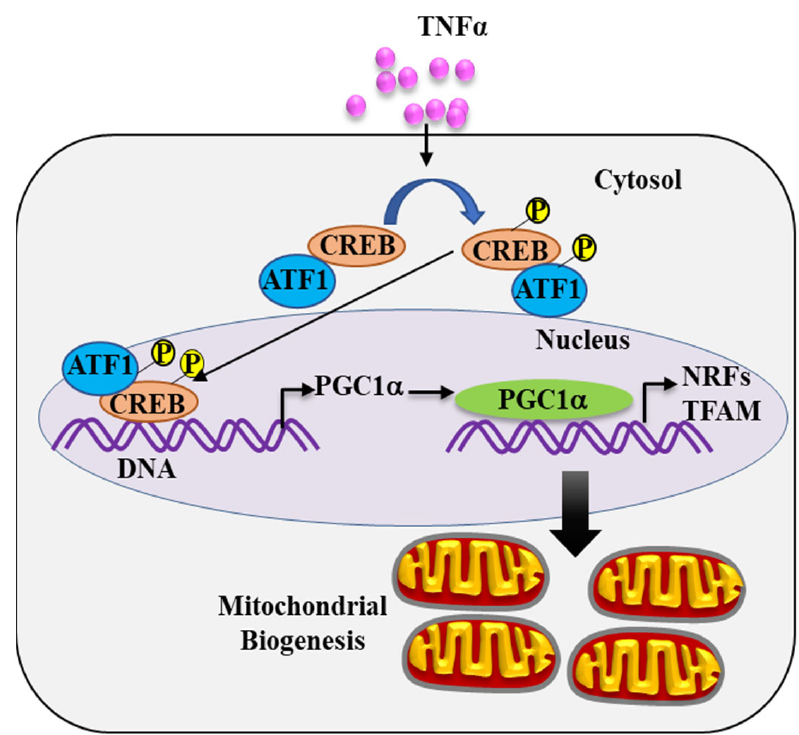
Figure 1. Conceptual framework. We hypothesize that TNF α triggers a signaling cascade involving phosphorylation of the transcription factors cAMP response element binding protein (pCREB S133 ) together with activating transcription factor 1 (pATF1 S63 ). pCREB S133 /pATF1 S63 binds to the peroxi ‐